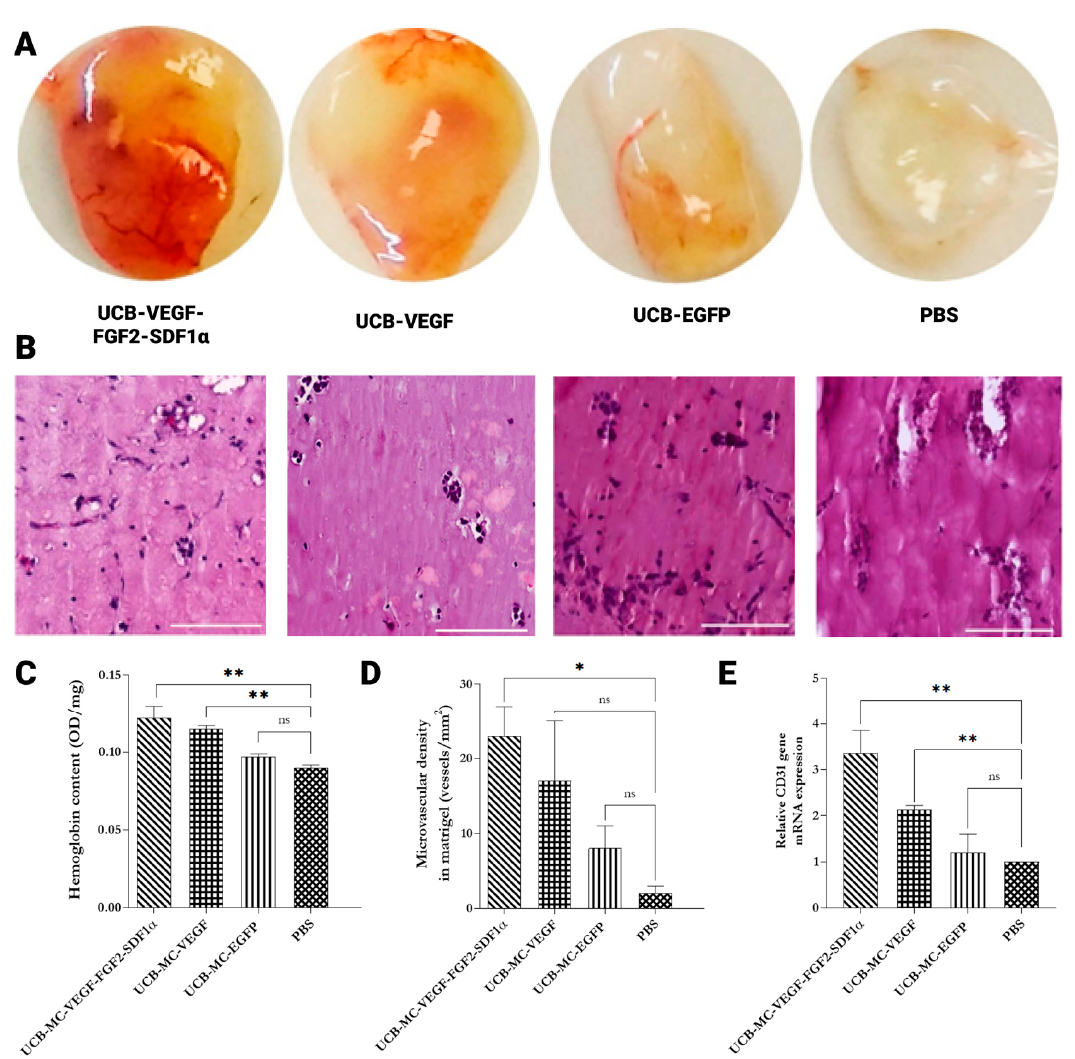
Figure 4. UCB-MC engineered with recombinant adenoviruses promotes angiogenesis in an in vivo Matrigel plug assay. Matrigel plugs collected at one-week post-implantation were appraised. ( A ) Representative gross morphological assessment and ( B ) microphotographs of harvested implants’ hematoxylin & eosin (H&E) staining. Scale bar 100 µm. ( C ) Quantification of hemoglobin concentration in each Matrigel plug ( n = 4). ( D ) Histomorphometric analysis of vascularization process, number of blood vessels in frozen sections of the Matrigel plugs. ( E ) RT-qPCR quantification of CD31 mRNA in Matrigel plugs. UCB-MC-VEGF-FGF2- SDF1 α —umbilical cord blood mononuclear cells modified with Ad-VEGF165, Ad-FGF2, and Ad-SDF1 α . UCB-MC-VEGF—umbilical cord blood mononuclear cells modified with Ad-VEGF165. UCB-MC-EGFP—umbilical cord blood mononuclear cells modified with Ad-EGFP. PBS—Matrigel containing PBS. Data presented as average ± standard error (SE); p < 0.05 * statistically significant differences compared to control ( n = 3; ** p < 0.01; ns—non-significant).